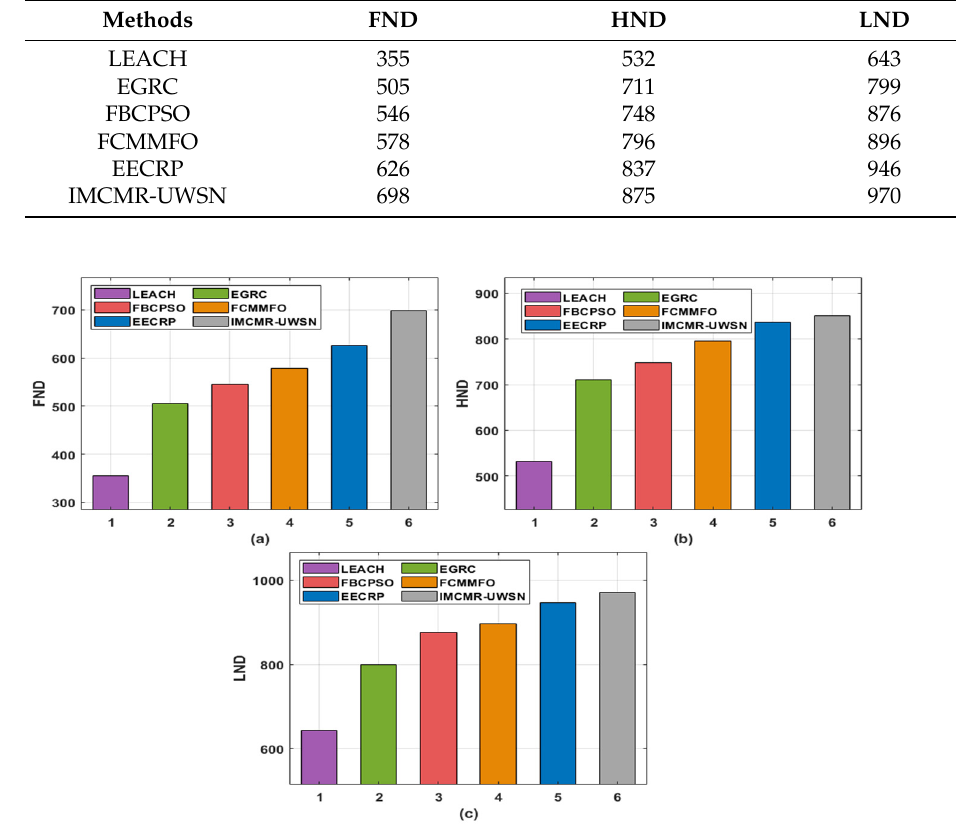
Figure 5. NLT analysis of IMCMR-UWSN technique with existing methods (a) FND; (b) HND; (c) LND.